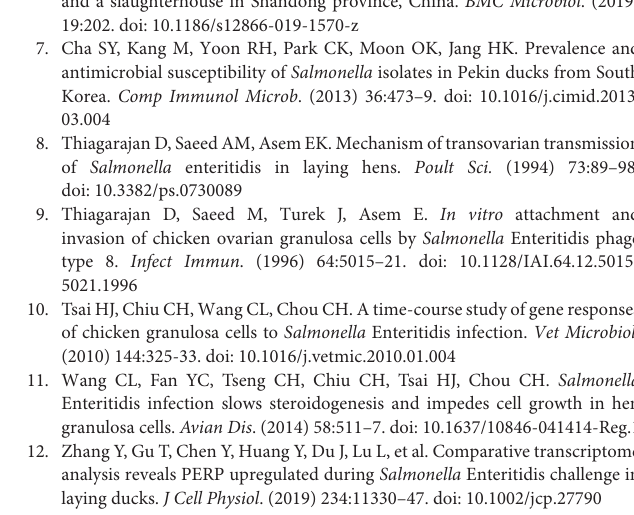
Supplementary Table 1 | Primers used in this study. Supplementary Table 2 | Primers used for construction of the luciferase reporter vector. Supplementary Table 3 | Summary of RNA sequencing for each sample. Supplementary Table 4 | Analysis of differentially expressed mRNAs between 0, 3, and 6 hpi. Supplementary Table 5 | Analysis of differentially expressed miRNAs between 0, 3, and 6 hpi. Supplementary Table 6 | Analysis of differentially expressed lncRNAs between 0, 3, and 6 hpi. Supplementary Table 7 | Analysis of differentially expressed circRNAs between 0, 3, and 6 hpi. Supplementary Table 8 | Gene ontology classification of differentially expressed mRNAs between 0, 3, and 6 hpi. Supplementary Table 9 | Gene ontology classification of differentially expressed miRNAs between 0, 3, and 6 hpi. Supplementary Table 10 | Gene ontology classification of differentially expressed lncRNAs between 0, 3, and 6 hpi. Supplementary Table 11 | Gene ontology classification of differentially expressed circRNAs between 0, 3, and 6 hpi. Supplementary Table 12 | Analysis of lncRNA-miRNA-mRNA regulatory networks during SE infection in duck granulosa cells. Supplementary Table 13 | Analysis of circRNA-miRNA-mRNA regulatory networks during SE infection in duck granulosa